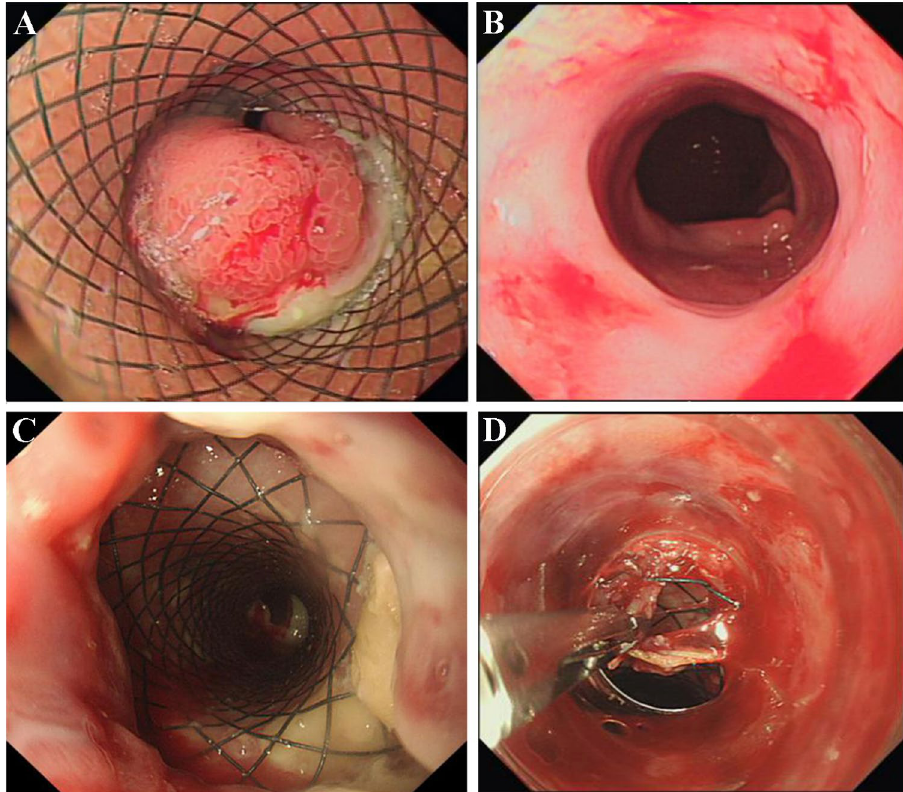
Figure 7. Management of adverse events related to long-term stent placement (cases 5 and 9). (In case 5) ( A ) Reactive inflammatory granulation tissue hyperplasia was seen at the bottom of the stent; ( B ) The esophageal lumen was changed following the removal of the third esophageal stent, the esophageal diameter was significantly enlarged without inflammatory granulation tissue hyperplasia noticed; (In case 9) ( C ) Stent embedding was caused by reactive tissue overgrowth; ( D ) The stent was not able to be removed on the first attempt but was successfully removed by biopsy forceps without perforation and active bleeding after part of the granulation tissue was